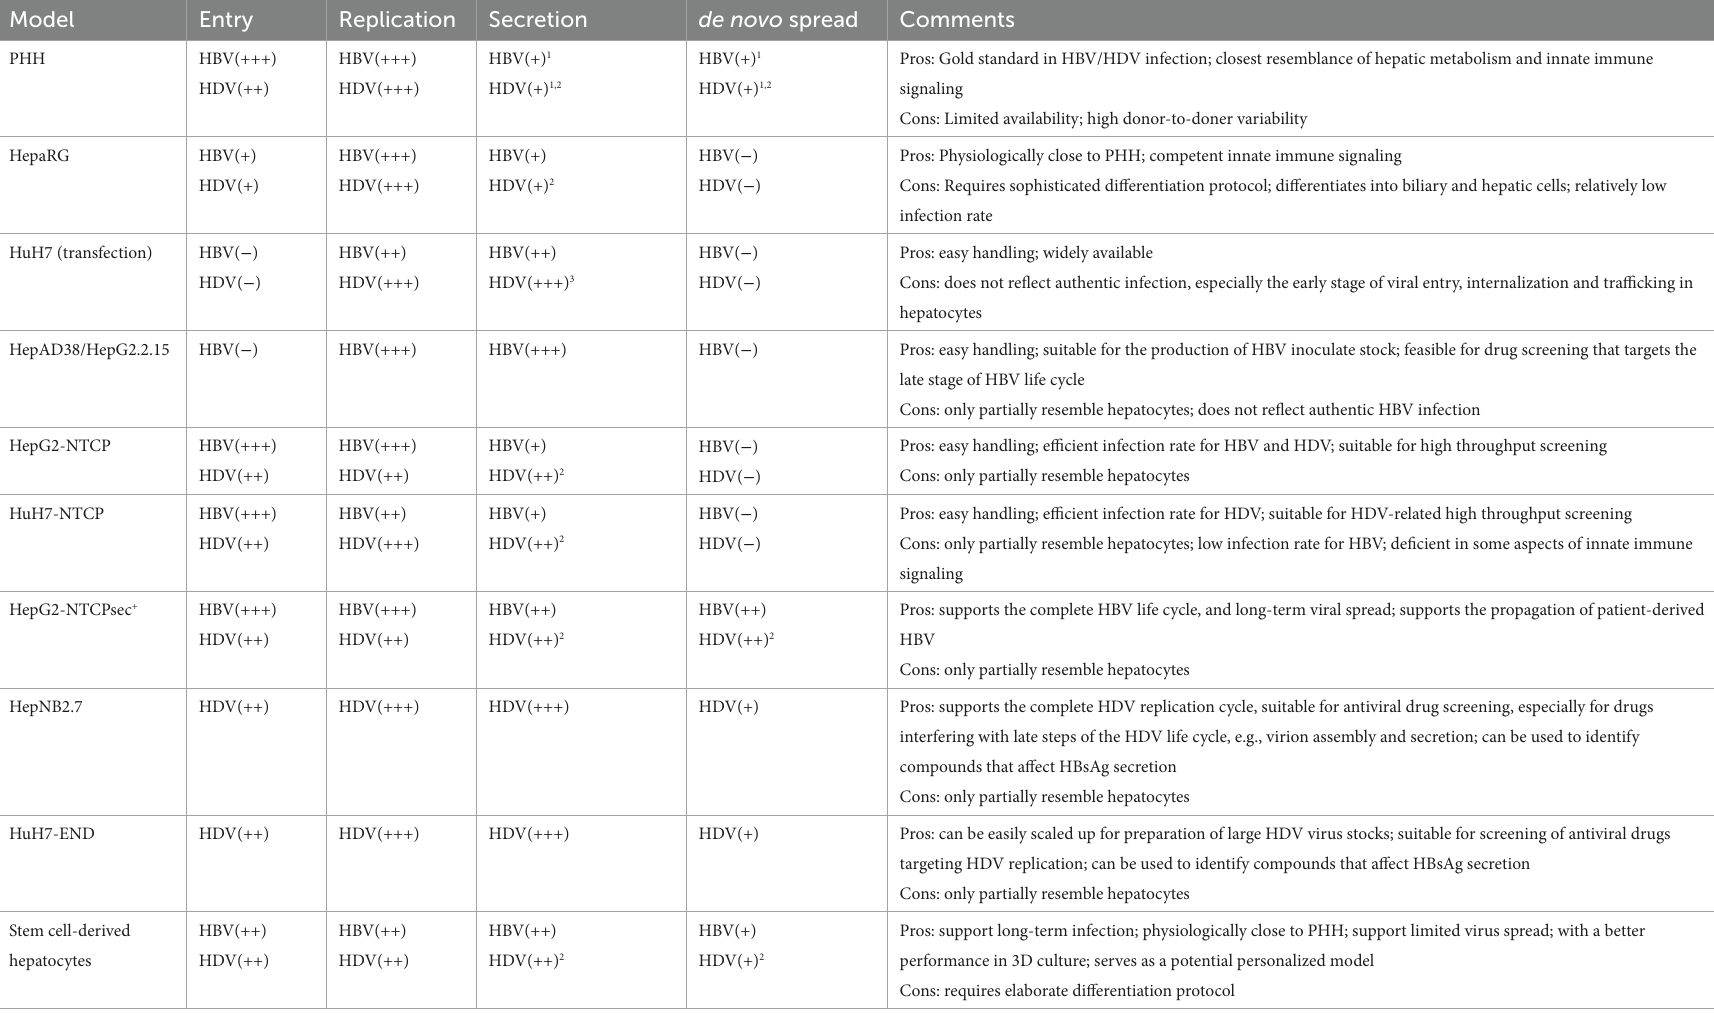
TABLE 1 Cell culture models for HBV and HDV